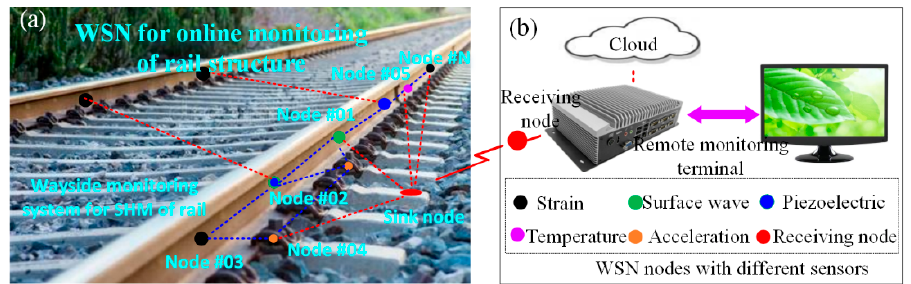
Figure 1. Long-distance rail structural health monitoring based on a WSN integrated with SMFS. ( a ) WSN nodes are laid out on the railway; ( b ) Monitoring terminal for long-distance rail.